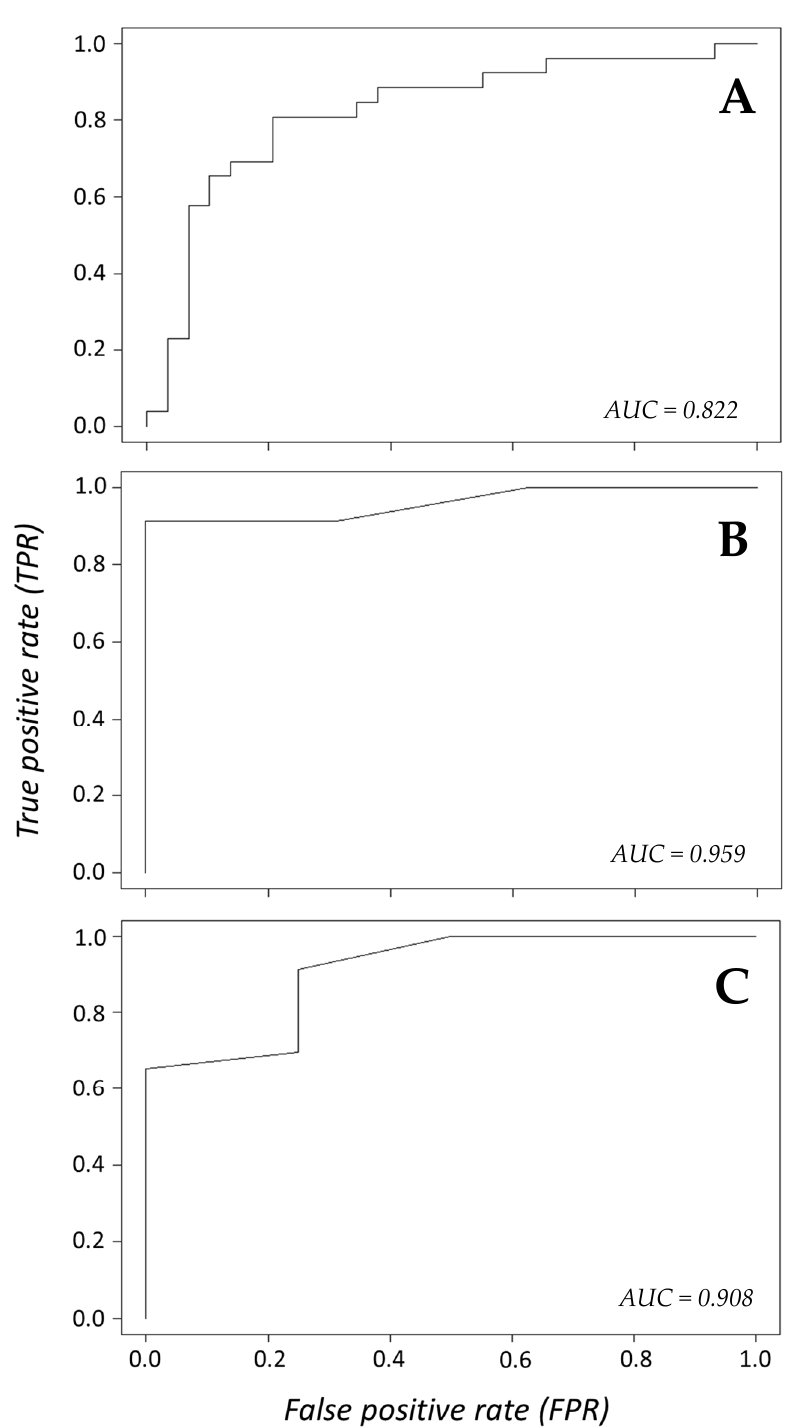
Figure 4. Receiver operating (ROC) plots with area under the curve (AUC) values depicting specificity of logistic regression models used to predict mortality as a result of blade strike conditions. Logistic models were produced for large rainbow trout and brook trout ( A ), small and large rainbow trout ( B ), or gizzard shad, American shad, and blueback herring ( C ).